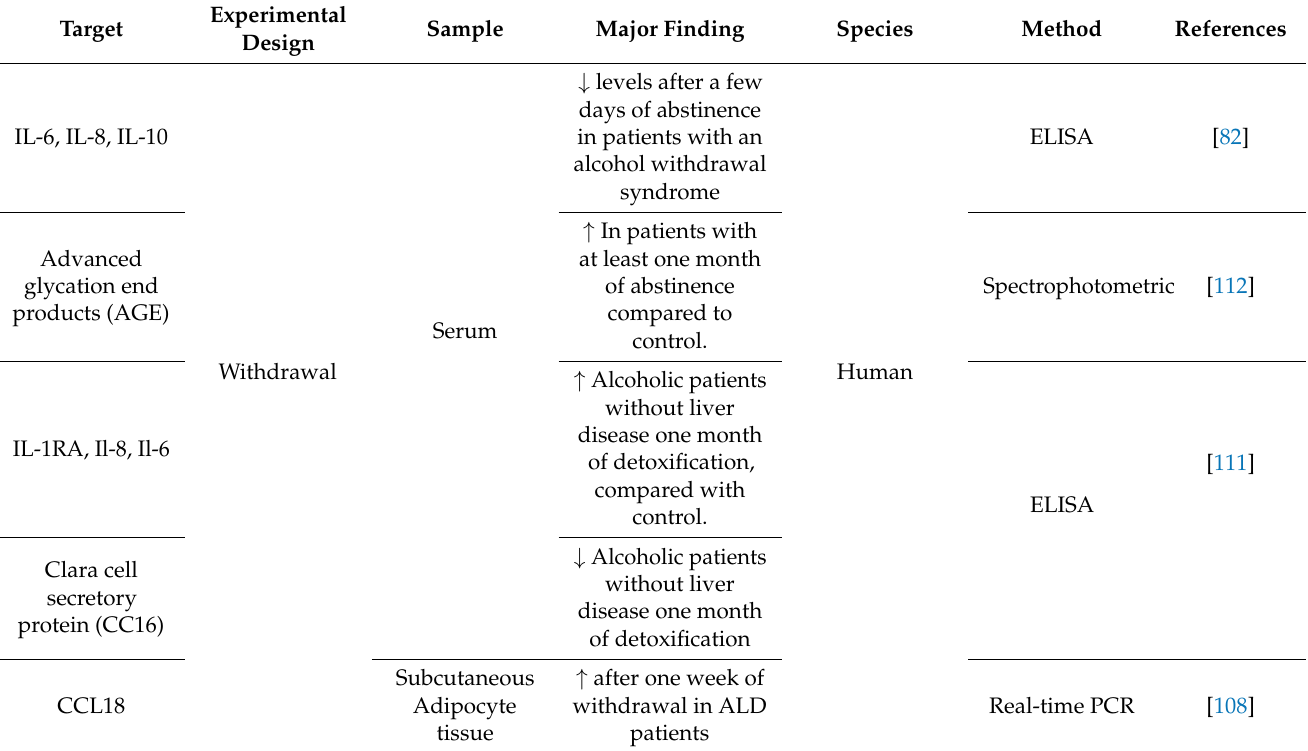
Table 4. Alcohol Use Disorder: